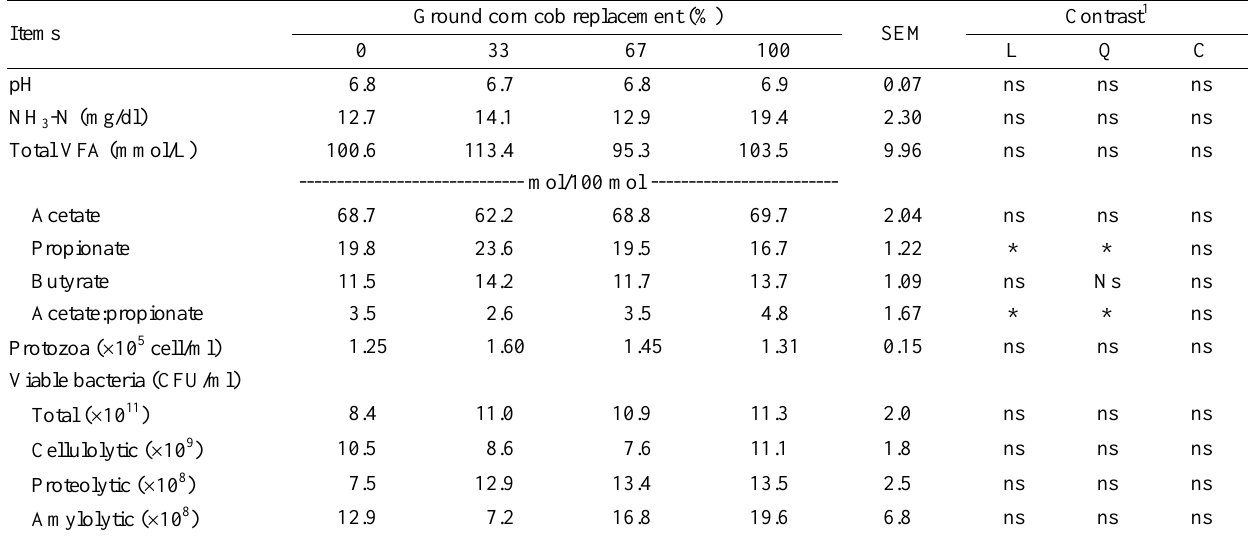
Table 3. Effect of ground corn cob replacement on ruminal pH, ammonia-nitrogen (NH 3 -N) and volatile fatty acid (VFA) concentrations in swamp buffalo